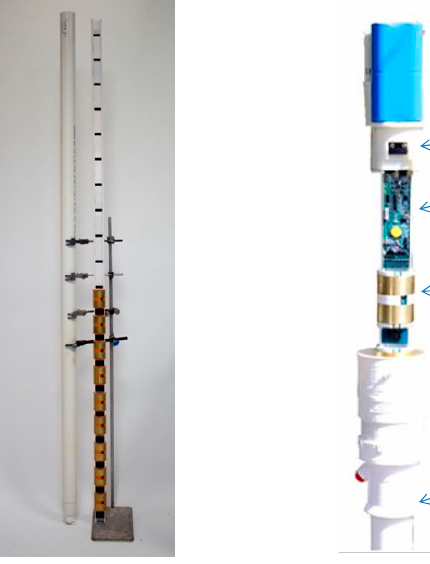
Figure 5. ( a ) The modem and battery; ( b ) The plastic holder and the electronic interface board.